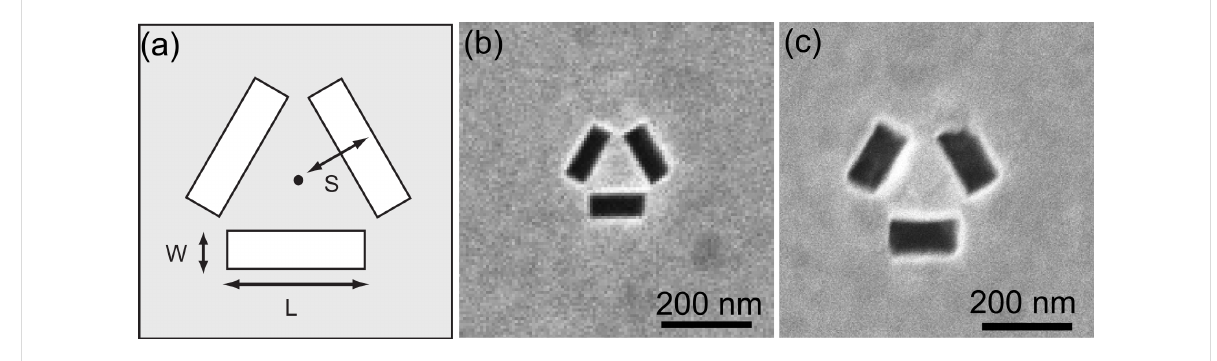
Figure 1: Scanning electron micrographs aperture structures with dimensions defined in (a). Fabricated slot trimer structures with (b) L = 95 nm, W = 34 nm and S = 60 nm, and (c) L = 150 nm, W = 40 and S = 100